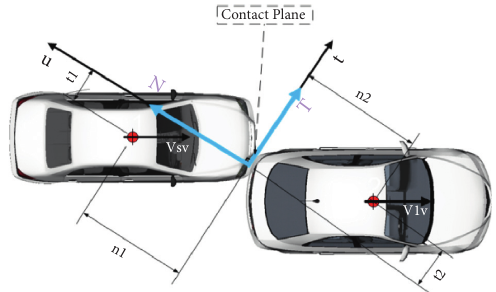
Figure 16: The impact configuration in PC-Crash.